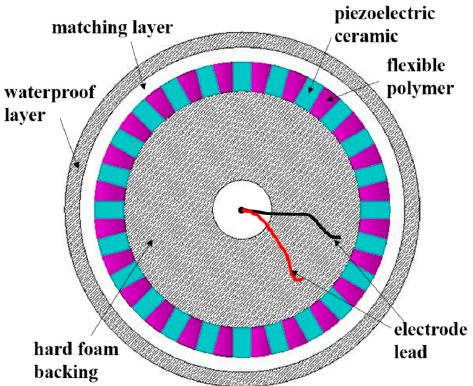
Figure 1. The structure of the high-frequency broadband composite cylindrical transducer.